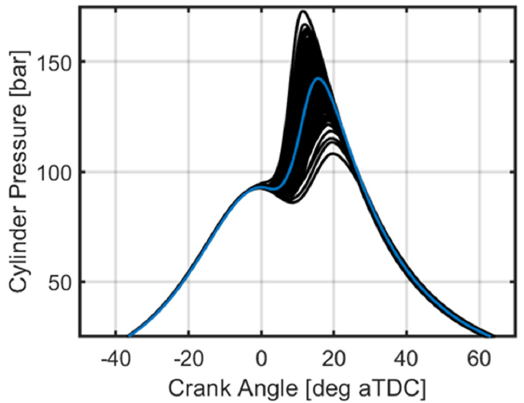
Figure 2. Cylinder pressure vs. crank angle of 300 individual cycles (black) and the average of 300 cycles (blue) for a purely kinetically-controlled combustion case.